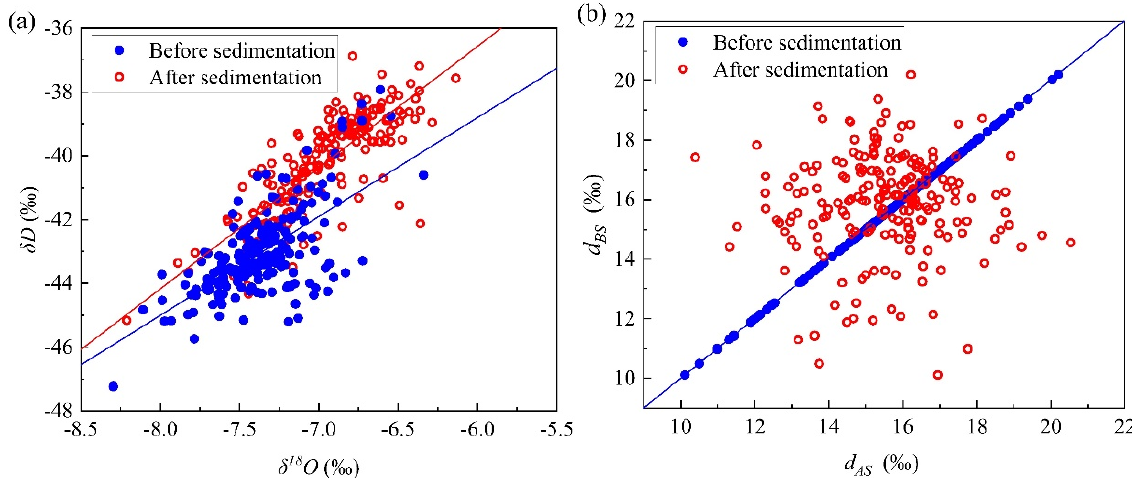
Figure 6. ( a ) Variation in linear fitting relationship between δ D and δ 18 O and ( b ) d value before and after micro-droplet groups deposition.